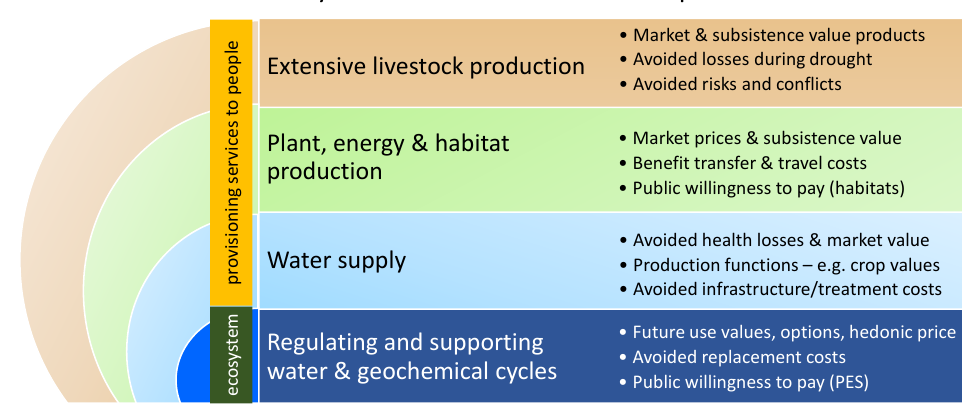
Figure 1. Goods and services in dryland